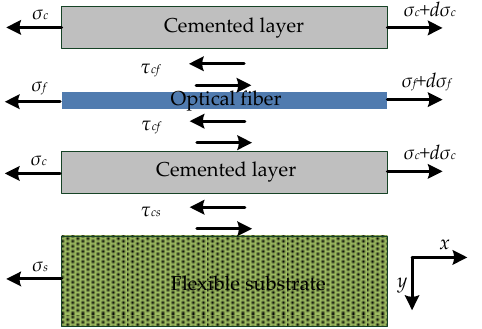
Figure 3. Schematic diagram of strain transfer between different layers in surface-bonded model.